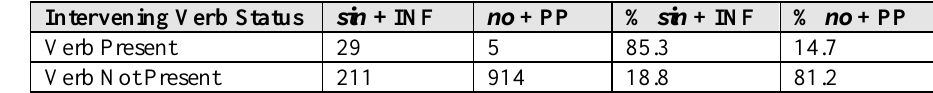
Table 4. Frequency of adjectival sin + INF and no + PP by intervening verb